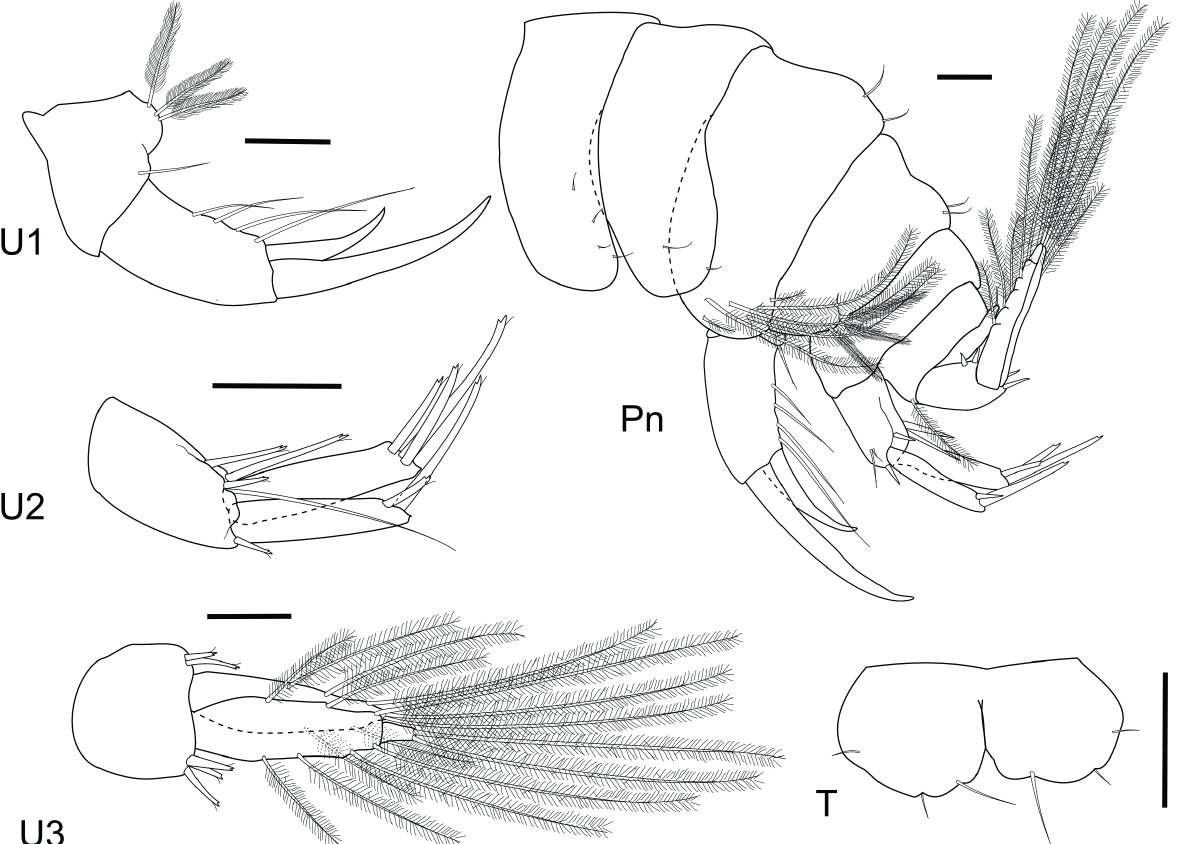
Figure 11 - Puelche longidactylus sp. nov. Female, 5.0 mm, MNRJ 28746: Uropods, pleon and telson. Scales = 0.1